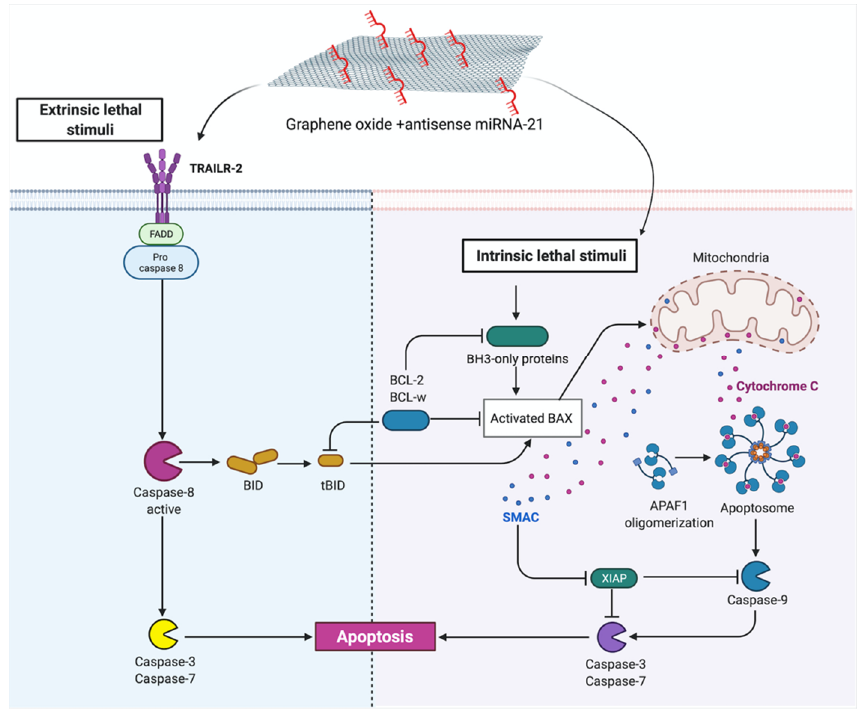
Figure 19. Protein interaction after graphene + antisense miRNA-21 complexes delivery into glioblastoma cells.